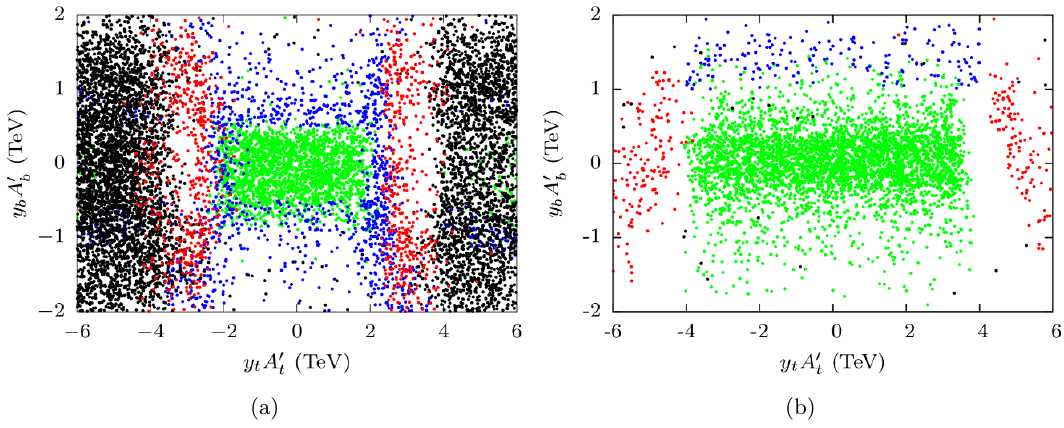
Figure 9 . Figures 9(a) and 9(b) classify by the parameter points according to the fate of DSB minima associated with them, in the y t A 0 (cid:0) y b A 0 plane, for low and high regime of tan (cid:12) . Figure 9 t b corresponds to the scan of eq. (3.5). It is evident that the e(cid:11)ect of A 0 is more prominent for low t tan (cid:12) , whereas A 0 plays a crucial role for large tan (cid:12) b